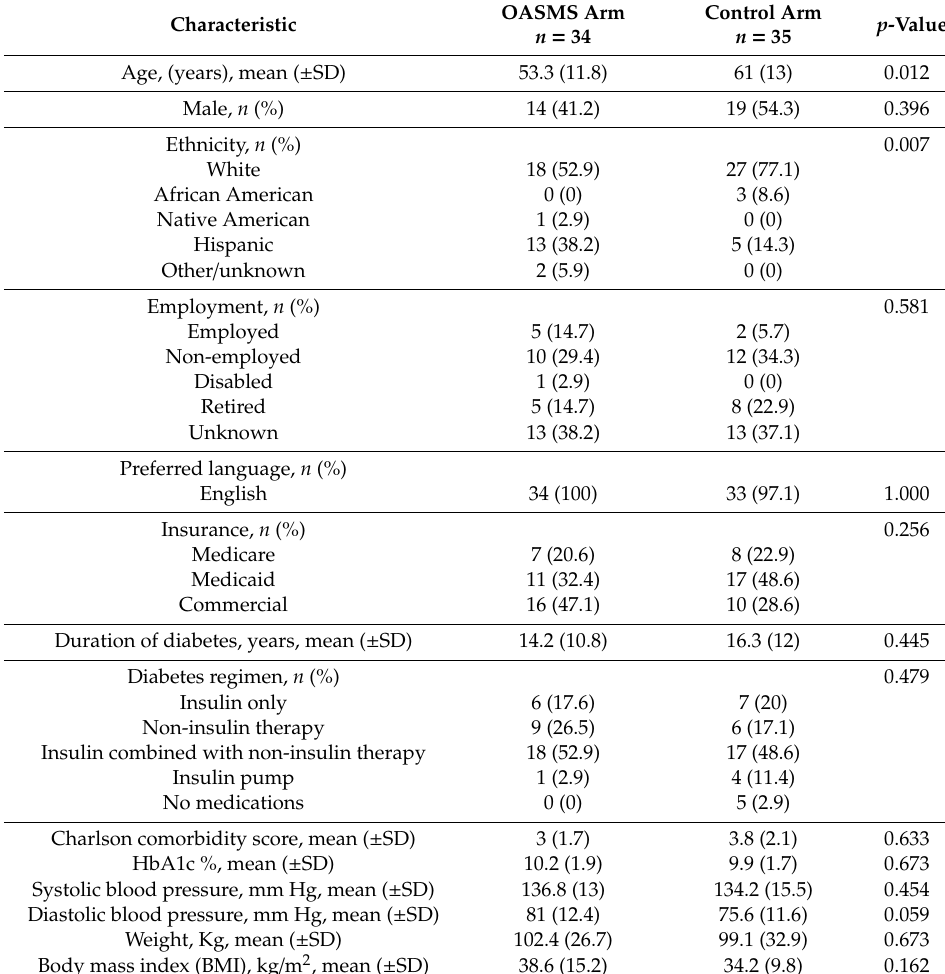
Table 2. Baseline characteristics.